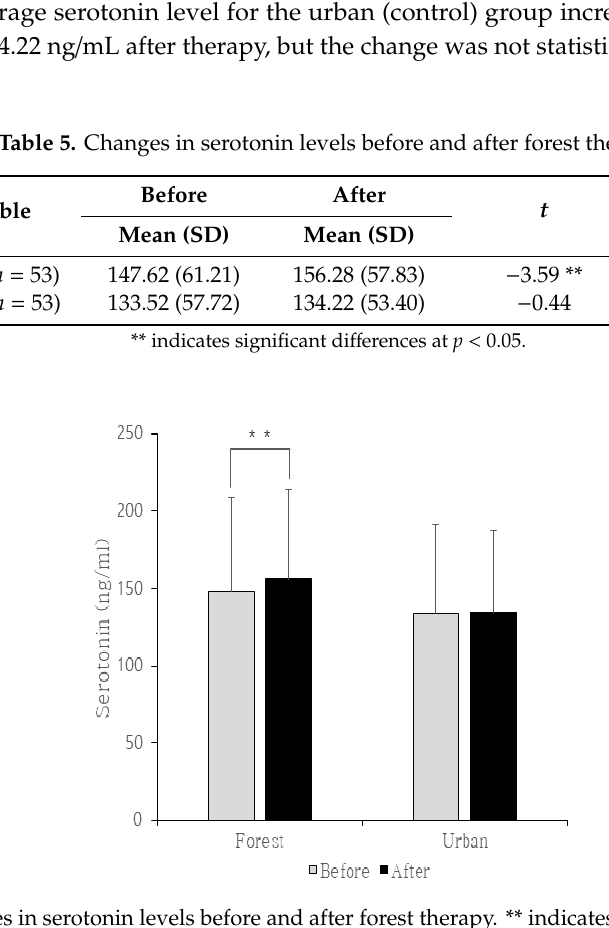
Figure 3. Changes in serotonin levels before and after forest therapy. ** indicates significant di ff erences at p < 0.05.